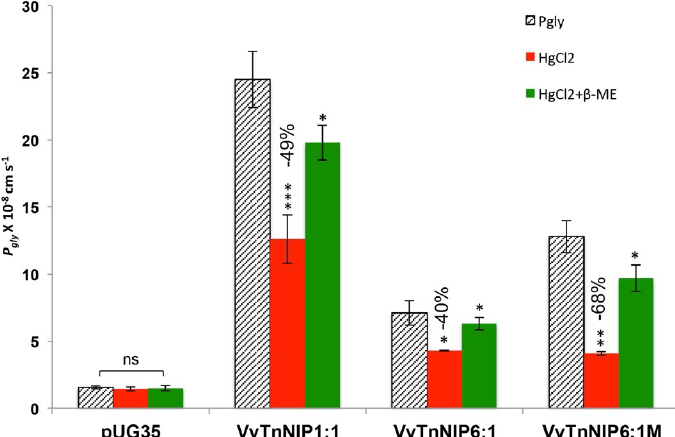
Figure 5. Inhibition of glycerol permeability ( P gly ) of grapevine NIPs by mercury chloride. Yeast strains expressing functional grapevine NIPs ( Vv TnNIP1;1, Vv TnNIP6;1, Vv TnNIP6;1M) showed 40–68% reduction in glycerol permeability in the presence of 0.5 mM mercury chloride. The reversal of the inhibitory e ff ect was observed when the cells were further incubated with 3 mM β -mercaptoethanol. Data is represented in the mean ± SD of three independent experiments with five traces. Statistically significant di ff erences are shown as an asterisk, calculated by t -test (* p < 0.05, ** p < 0.01, and *** p <